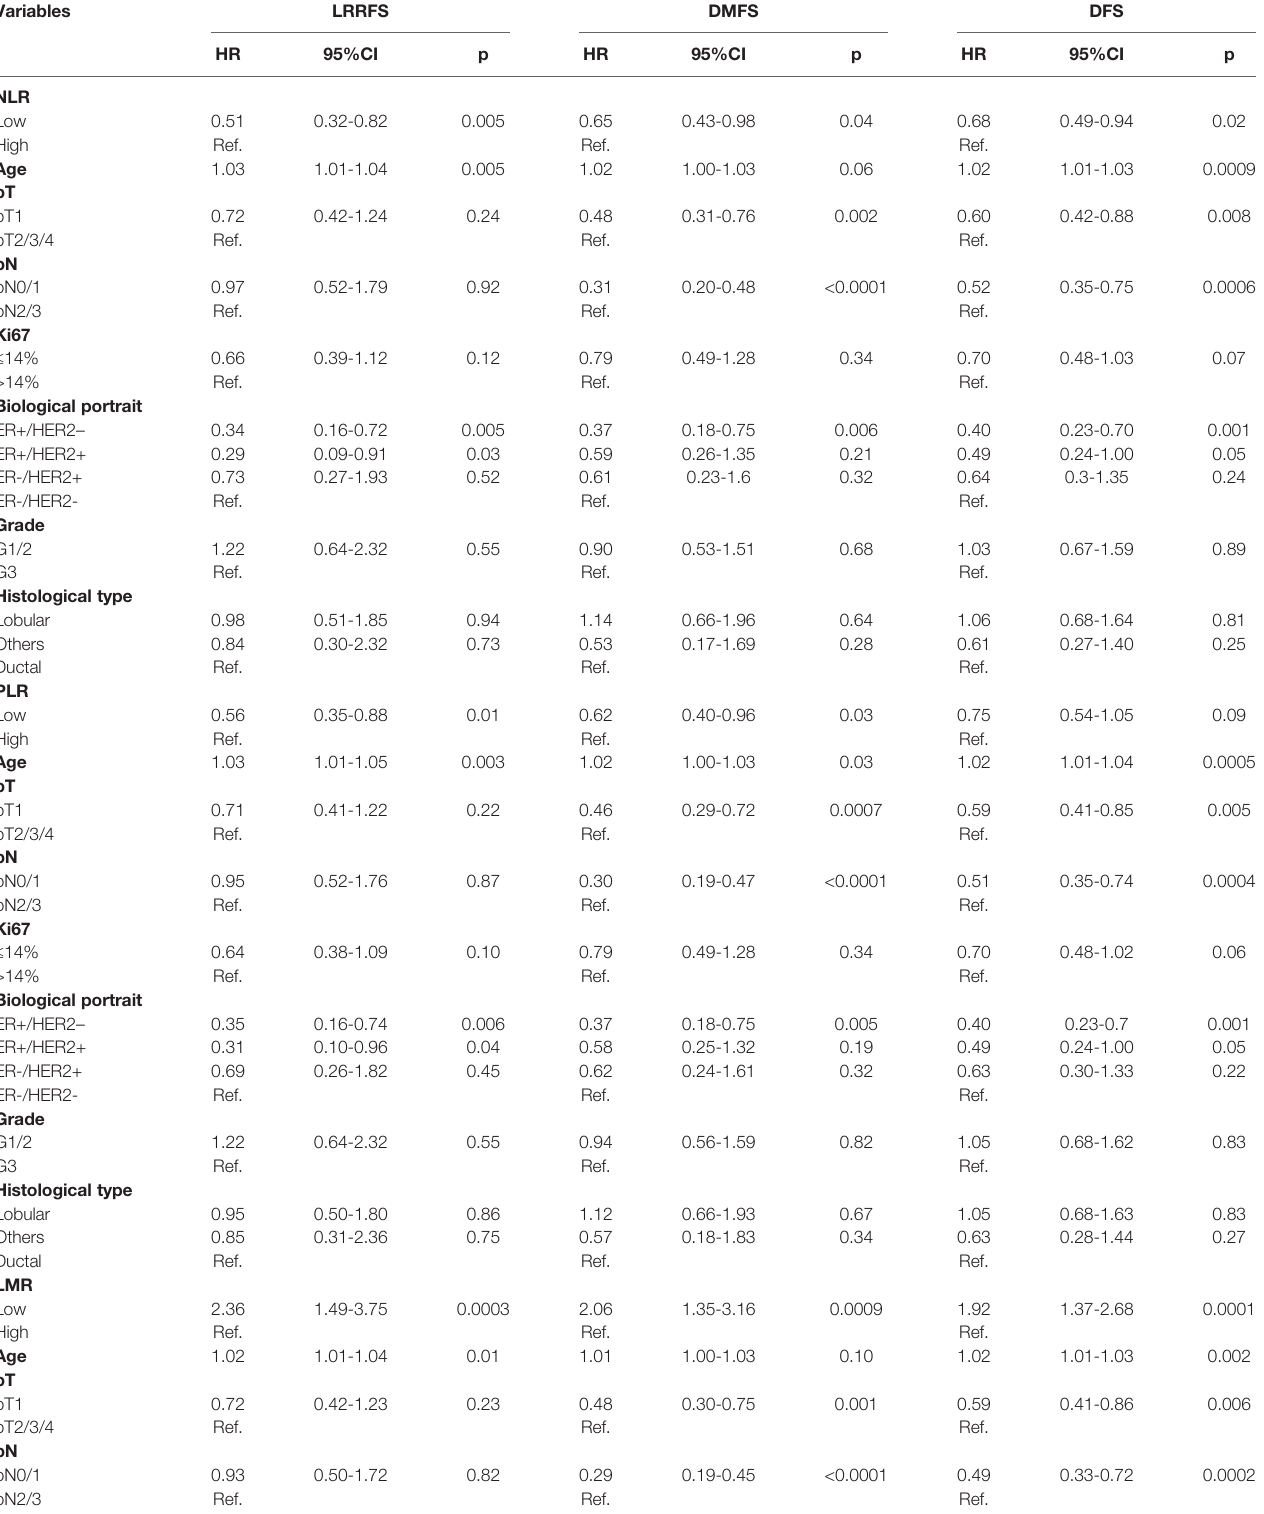
TABLE 2 | Multivariate analysis of in fl ammatory and clinical characteristics in relation to 5-years LRRFS, DMFS, DFS in the study population